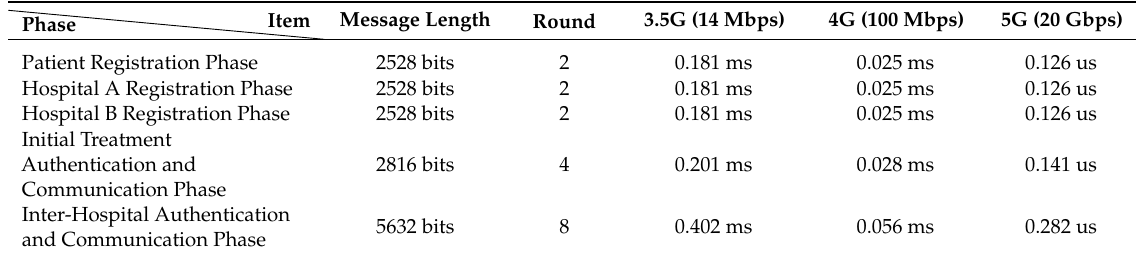
Table 3. Communication cost of the proposed